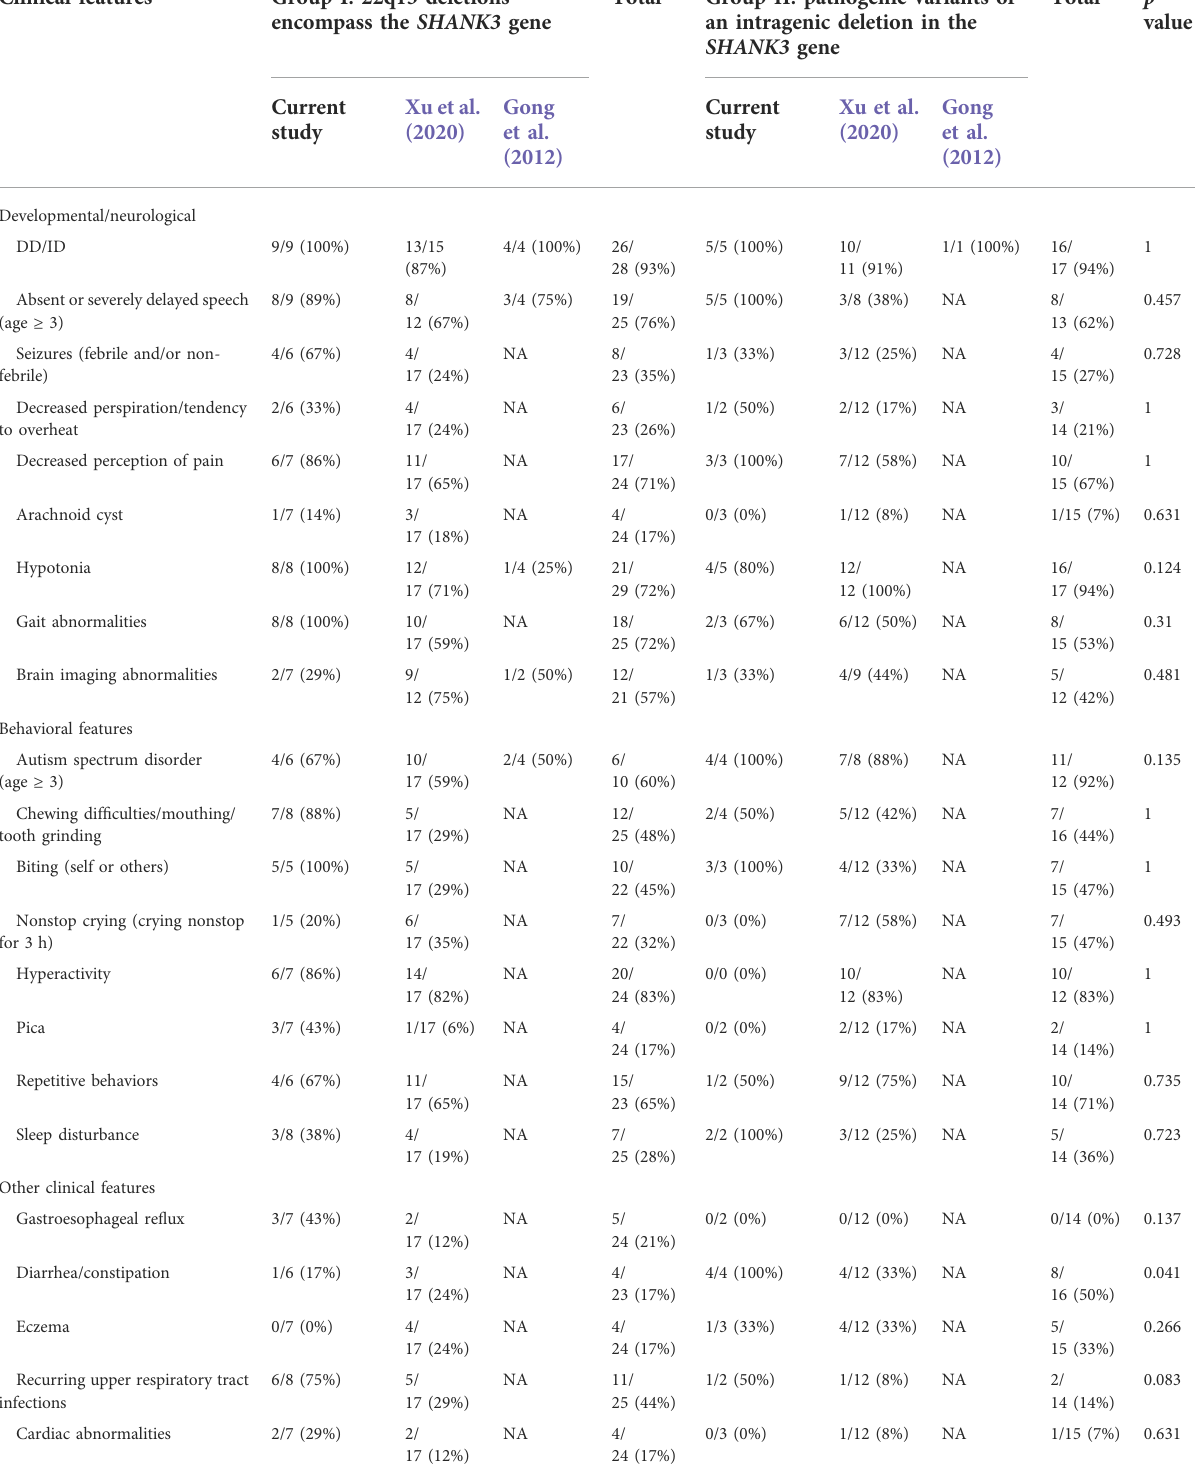
TABLE 4 Comparison of postnatal phenotypes between patients with deletions at 22q13 and pathogenic variants or an intragenic deletion in the SHANK3 gene than SHANK3 gene and loss of SHANK3